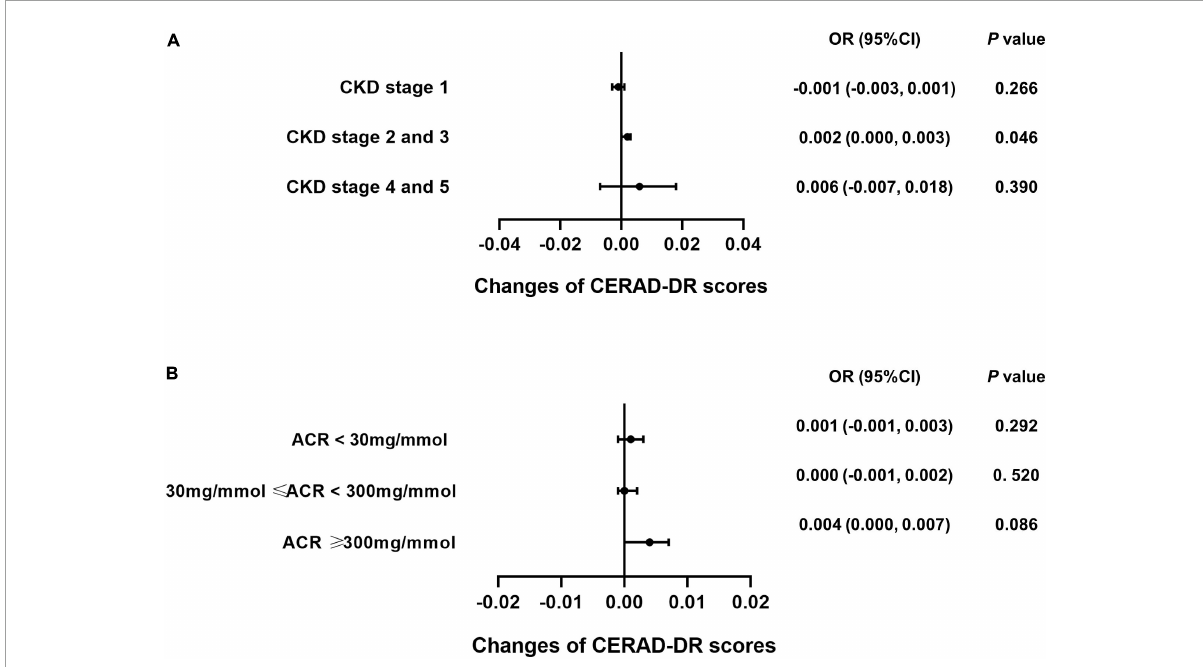
FIGURE4 Caffeine only improves the results of the Consortium to Establish a Registry for Alzheimer’s Disease Word List Recall Test (CERAD-DR) for CKD stage 2 and 3 patients. Logistic regression analysis of caffeine intake and CERAD-DR scores was performed for the CKD stage (CKD stage 1 = 59 subjects, CKD stage 2 and 3 = 362 subjects, CKD stage 4 and 5 = 21 subjects) or urinary albumin creatinine ratio (ACR) subgroups (ACR < 30 mg/mmol = 196 subjects, 30 mg/mmol ≤ ACR < 300 mg/mmol = 210 subjects, ACR ≥ 300 mg/mmol = 36 subjects). Subgroup analysis showed that caffeine improved the results on the CERAD-DR in CKD stage 2 and 3 patients only (OR = 0.002, 95% CI: 0.000–0.003, P = 0.046, A ). No beneficial effects were found among the ACR subgroups (B) .